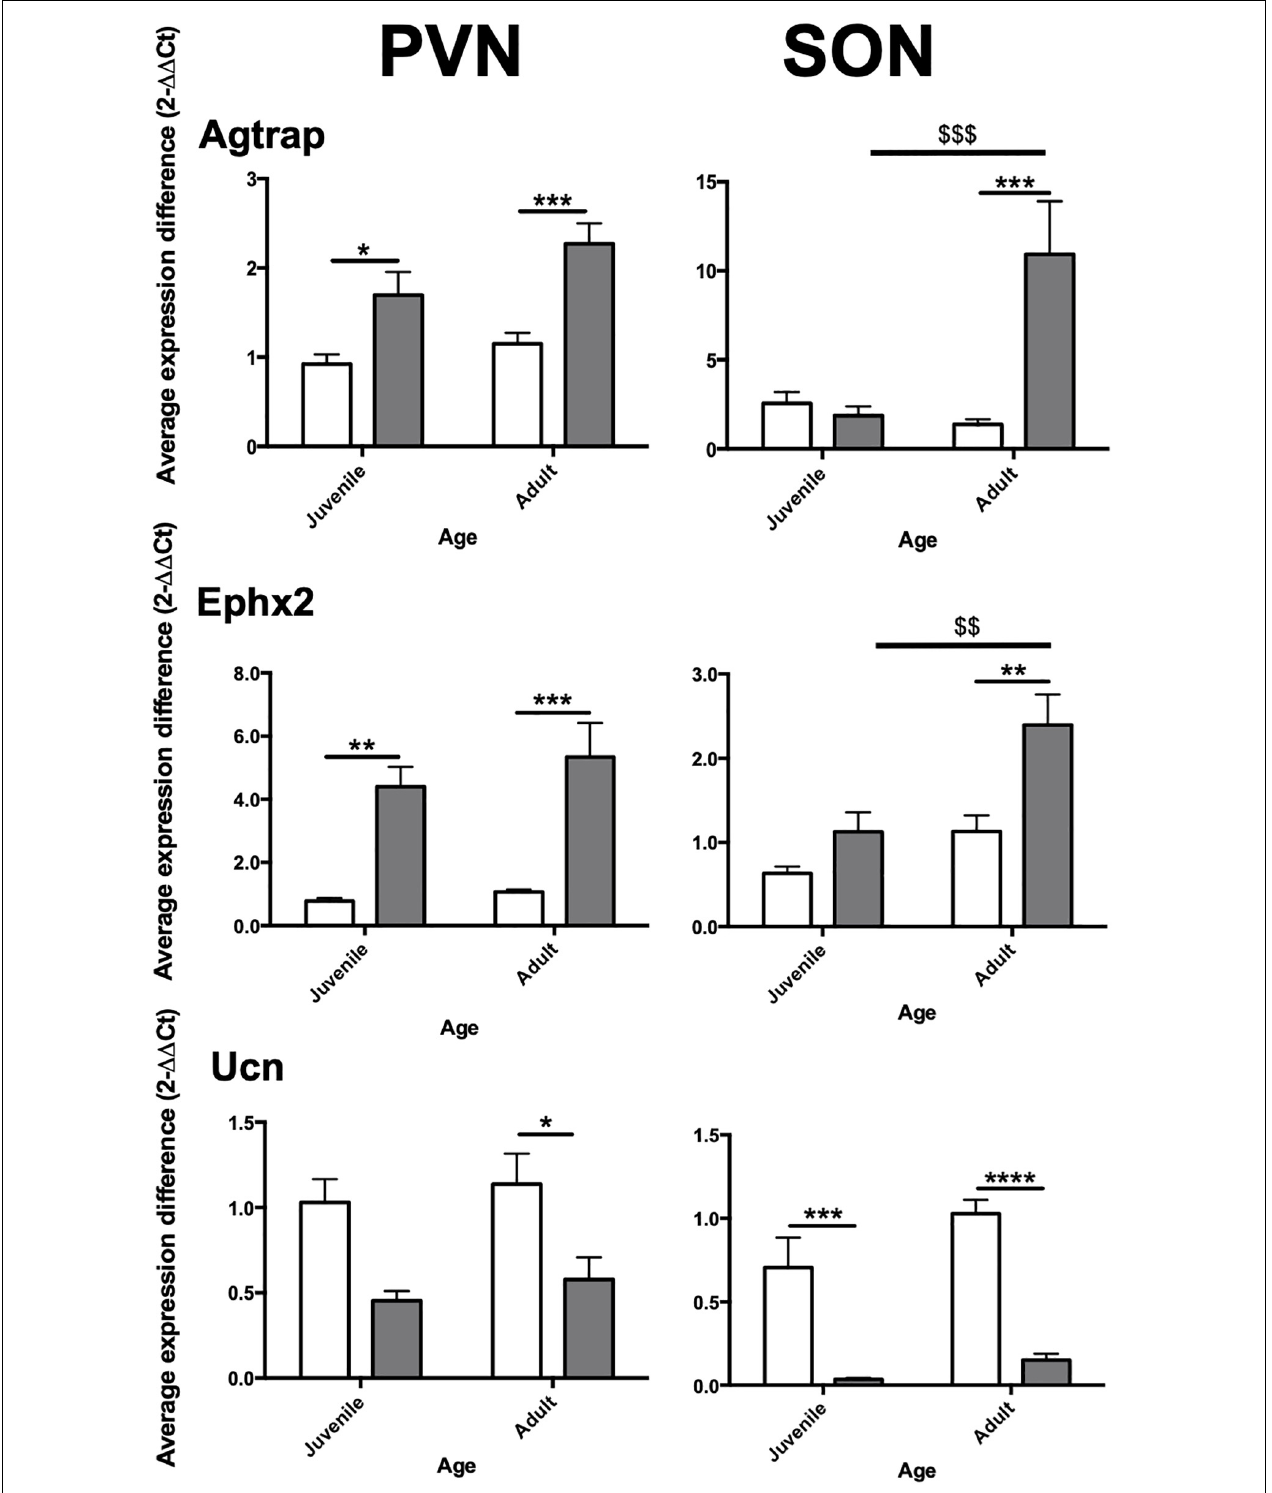
FIGURE 2 | Relative expression of selected genes in PVN and SON in aged-matched WKY vs. SHR. Agtrap, Type-I Angiotensin II receptor-associated protein; Ucn, Urocortin; Ephx2, Soluble Epoxide Hydrolase gene. Juvenile = 6 weeks, adult = 12 weeks. Asterisks (*) indicate inter-strain significant differences within age. Dollar signs ($) indicate intra-strain significant differences between age. White bars: WKY. Black bars: SHR. Significance as follows; * p ≤ 0.05, **/$$ p ≤ 0.01, ***/$$$ ≤ p ≤ 0.001, **** p < 0.0001. Error bars = Standard Error of Mean (S.E.M.).